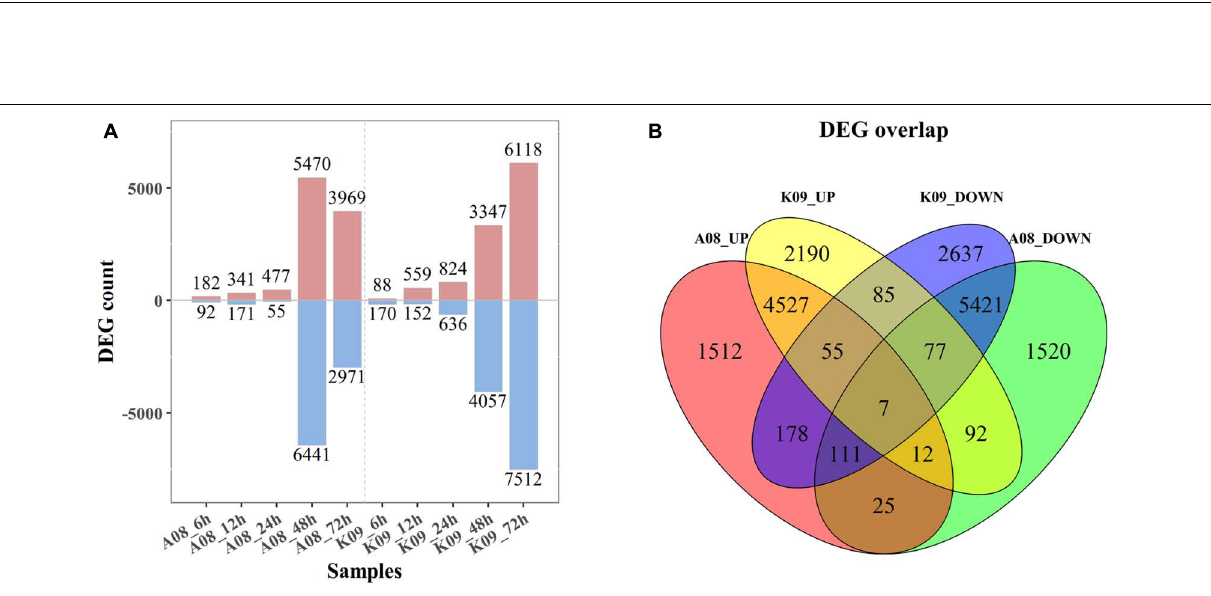
Frontiers in Plant Science |